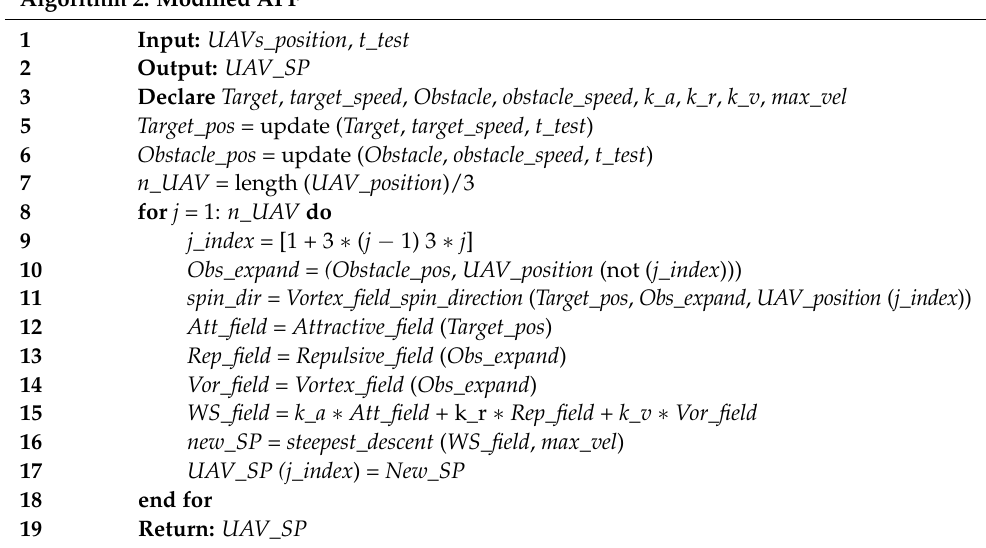
Algorithm 2: Modified